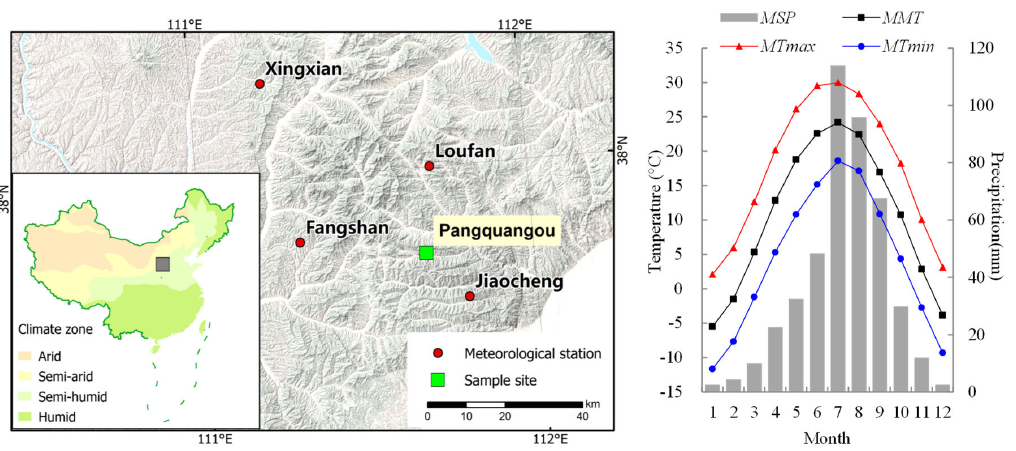
Figure 1. Site map and monthly mean temperature and monthly mean precipitation according to the records of meteorological stations in Jiaocheng County (1959–2017). MMT, Month mean temperature; MSP, Monthly sum of precipitation; MTmin, Monthly minimum temperature; MTmax, Monthly maximum temperature.